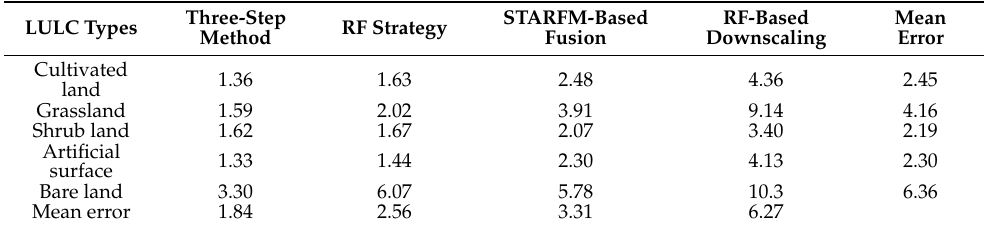
Table 4. Average distribution errors of the four predicted LST images at five land-cover types in Image A1 (K).